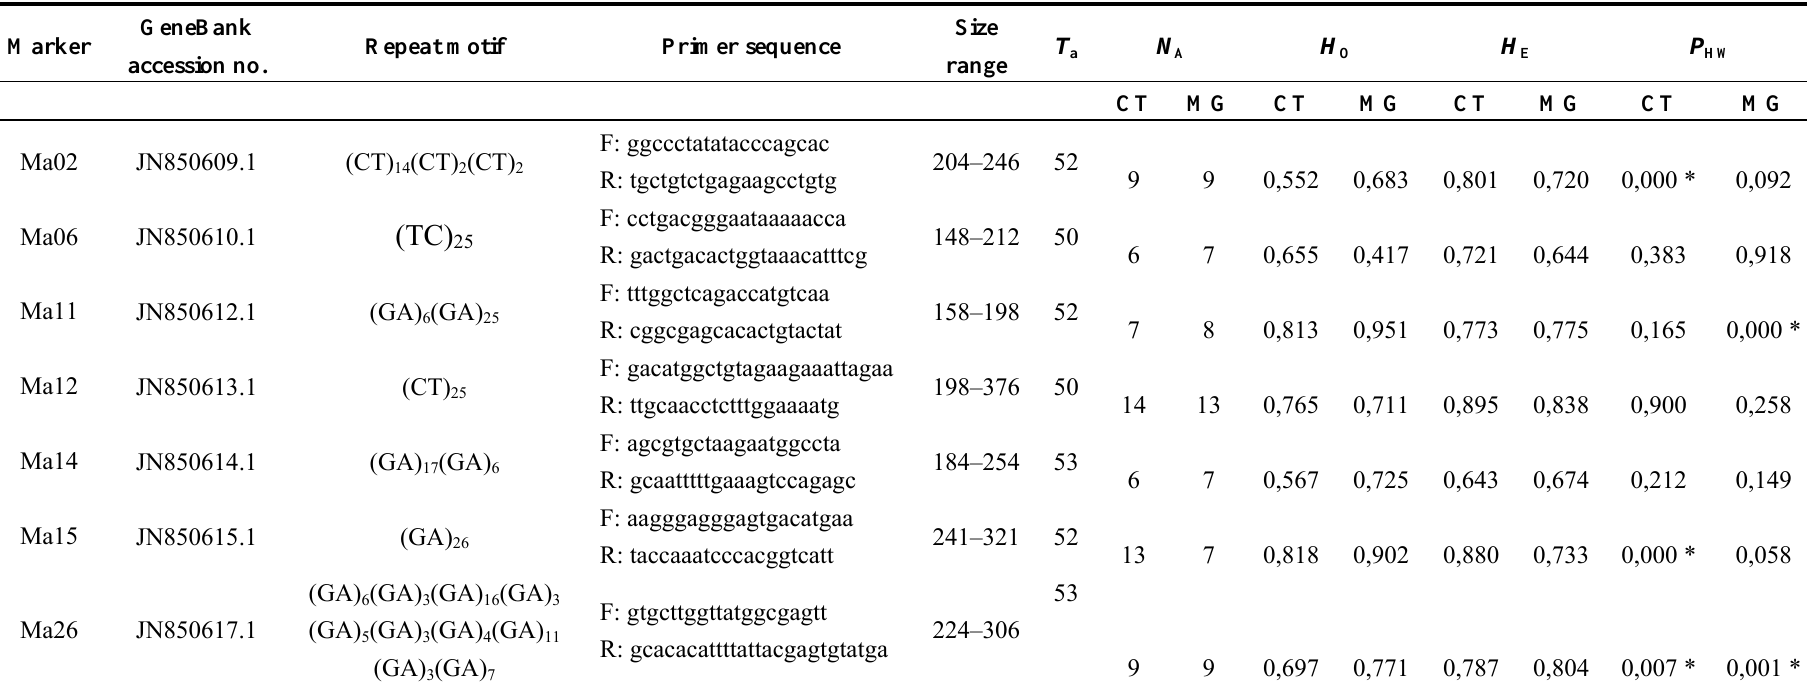
Table 1. Primer sequences and characteristics of the nine microsatellite loci successfully amplified in Mya arenaria .